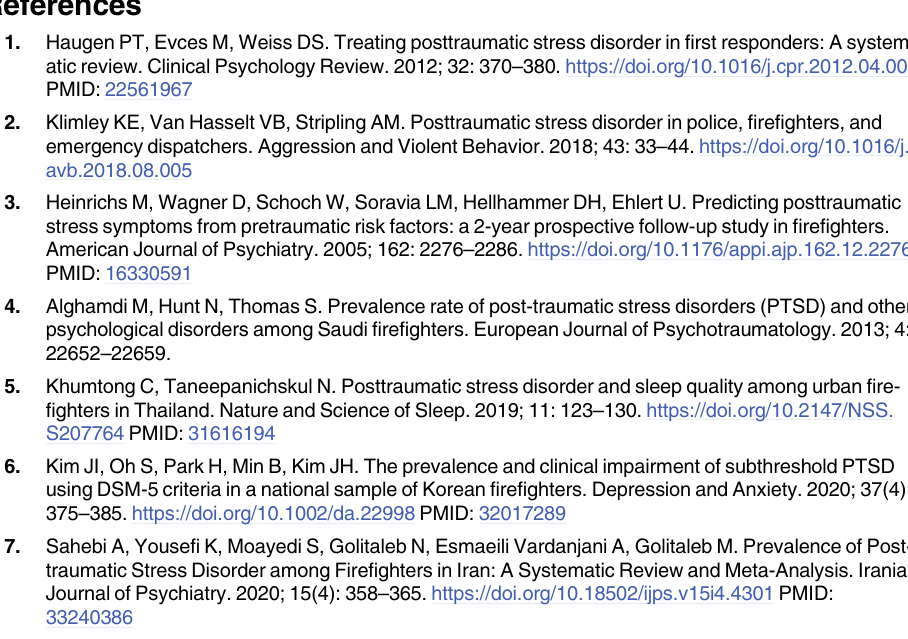
S1 Table. Results of the backward stepwise